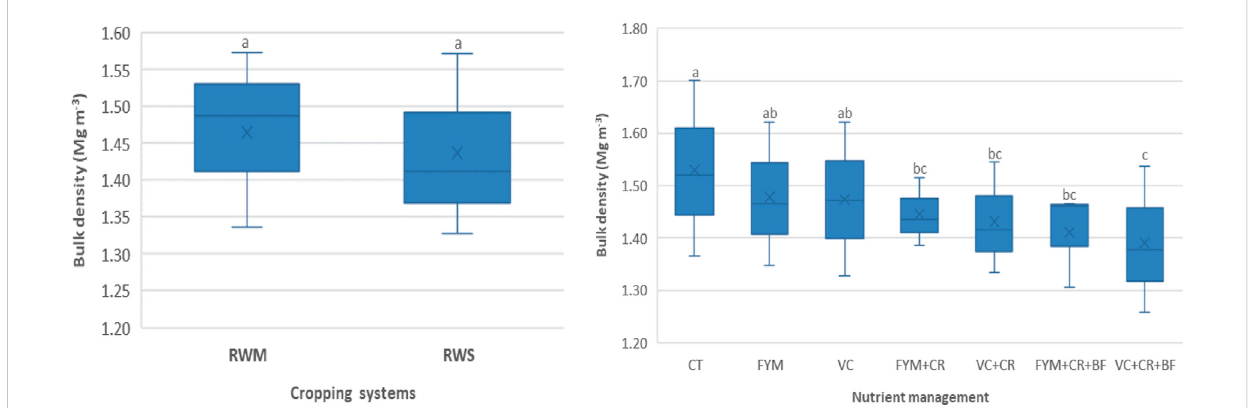
FIGURE 4 Long-term effect of cropping systems and organic nutrient management on soil BD. BD: bulk density; RWM: rice-wheat-mung bean; RWS: rice- wheat-sesbania; CT: control; FYM: farm yard manure; VC: vermicompost; CR: crop residue(s); and BF: biofertilizer(s). Statistical method: analysis of variance for strip-plot design in SAS 9.3 software; n = 42. Values with a different capital letter indicate a signi fi cant difference among the different treatments at p < 0.05 by the LSD test. Bars represent means ± SEM.